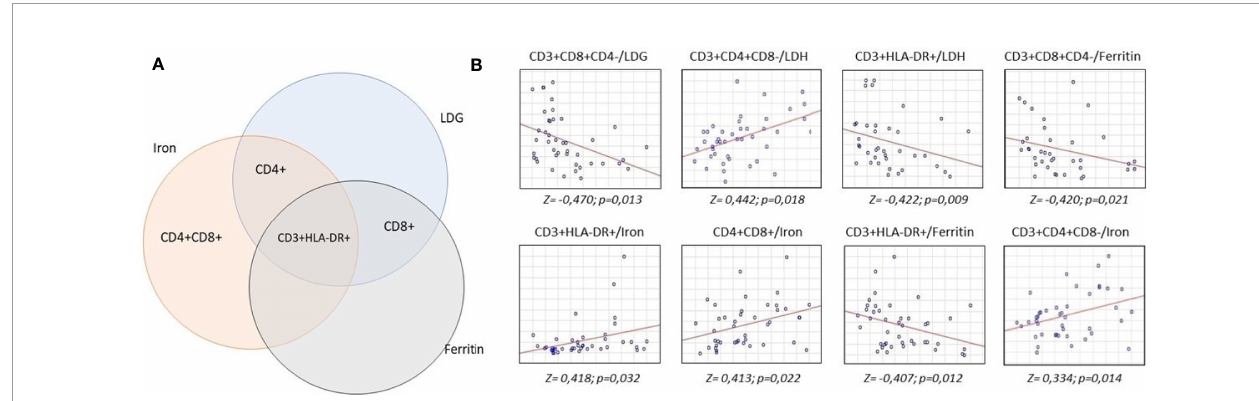
FIGURE 2 | Analysis of correlations of serum concentrations of lactate dehydrogenase, iron and ferritin with lymphocyte subpopulations. 16 ml of whole venous blood out of 43 patients was analyzed to measure lactate dehydrogenase, iron and ferritin levels and lymphocyte subpopulation count. Biochemical analysis was carried out by the colorimetric method, lymphocyte subpopulations studied by fl ow cytometry. Statistical analysis to fi nd the relationship between these parameters was carried out according to Spearman test. (A) intersection of correlations between biochemical parameters and lymphocyte subpopulations. (B) revealed positive (upward axis) and negative (downward axis) correlations between lymphocyte subpopulations and biochemical parameters.